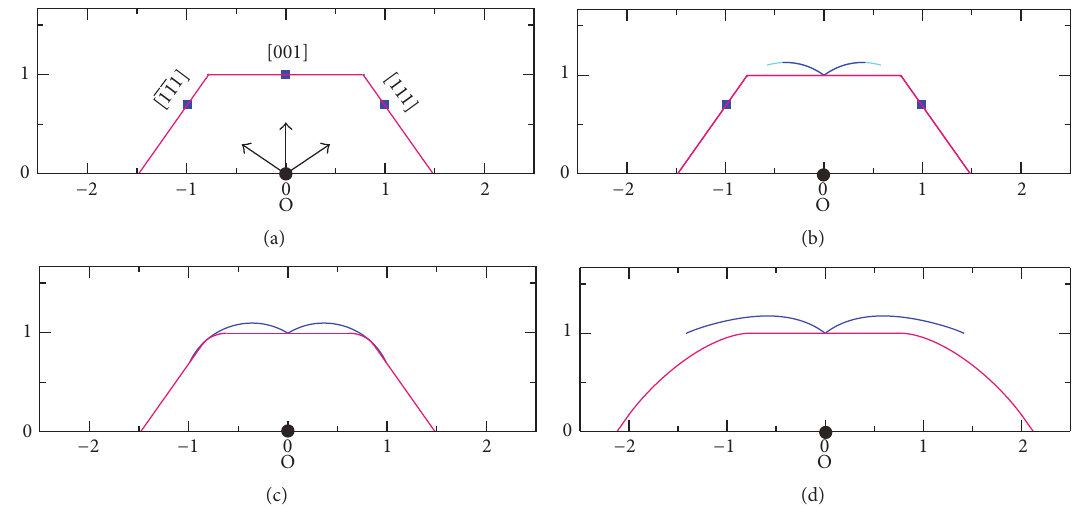
Figure 5: (a) 𝑘 𝐵 𝑇/𝜖 = 0.6 , 𝜖 int /𝜖 = −0.9 (in the step-faceting zone). (b) 𝑘 𝐵 𝑇/𝜖 = 0.63 , 𝜖 int /𝜖 = −0.9 (in step droplet zone I). (c) 𝑘 𝐵 𝑇/𝜖 = 0.73 , 𝜖 /𝜖 = −0.9 (in GMPT zone I). (d) 𝑘 𝑇/𝜖 = 0.6 , 𝜖 = 0 (original RSOS model). Red lines: 𝑍(𝑅) calculated by the DMRG method. Blue lines int 𝐵 int and filled blue squares: polar graph of surface tension 𝛾 surf (𝜃)/𝜖 ( −54.74 ∘ < 𝜃 < 54.74 ∘ ), where 𝜃 is the tilt angle of the vicinal surface from the (001) surface towards the direction ⟨111⟩ . The pale blue lines in (b) indicate the values for the metastable surfaces. The end points of the pale blue lines show the spinodal points approximately. Point O represents the Wulff point. We assume 𝜖 surf is equal to 𝜖 .